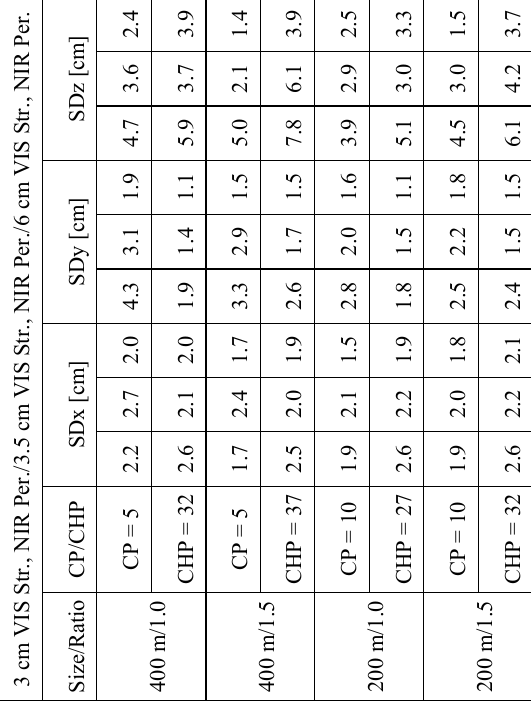
Table 8. Standard deviations of control points and check points measured by RTK GNSS method